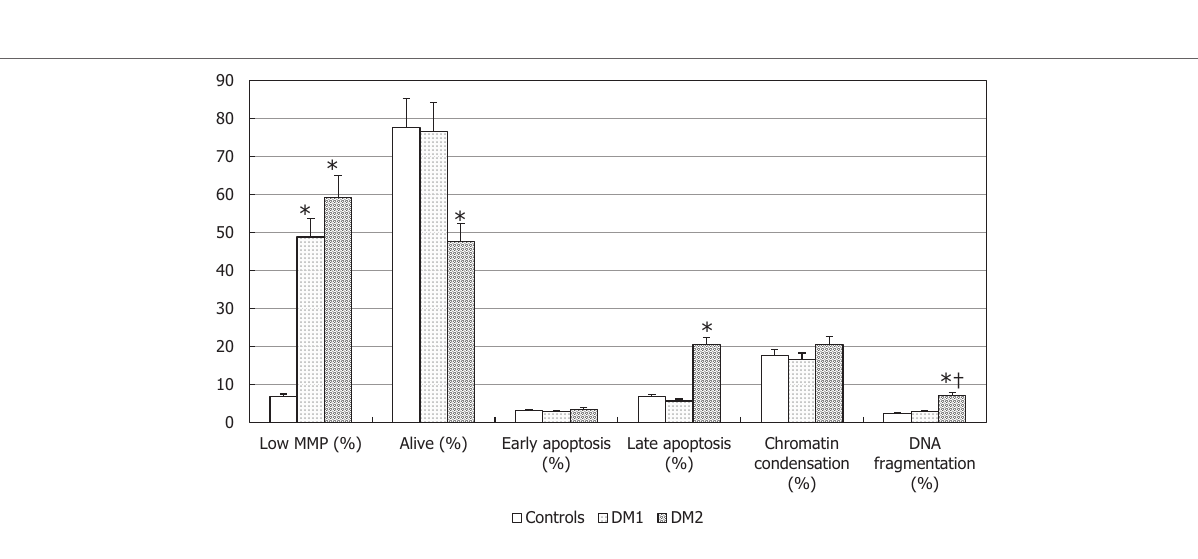
FigUre 3 | Biofunctional sperm parameters in patients with type 1 diabetes mellitus (DM1), type 2 diabetes mellitus (DM2), and control (CTL) group. * p < 0.05 vs. CTL; † p < 0.05 vs. DM1. The results are expressed as mean ± SEM.